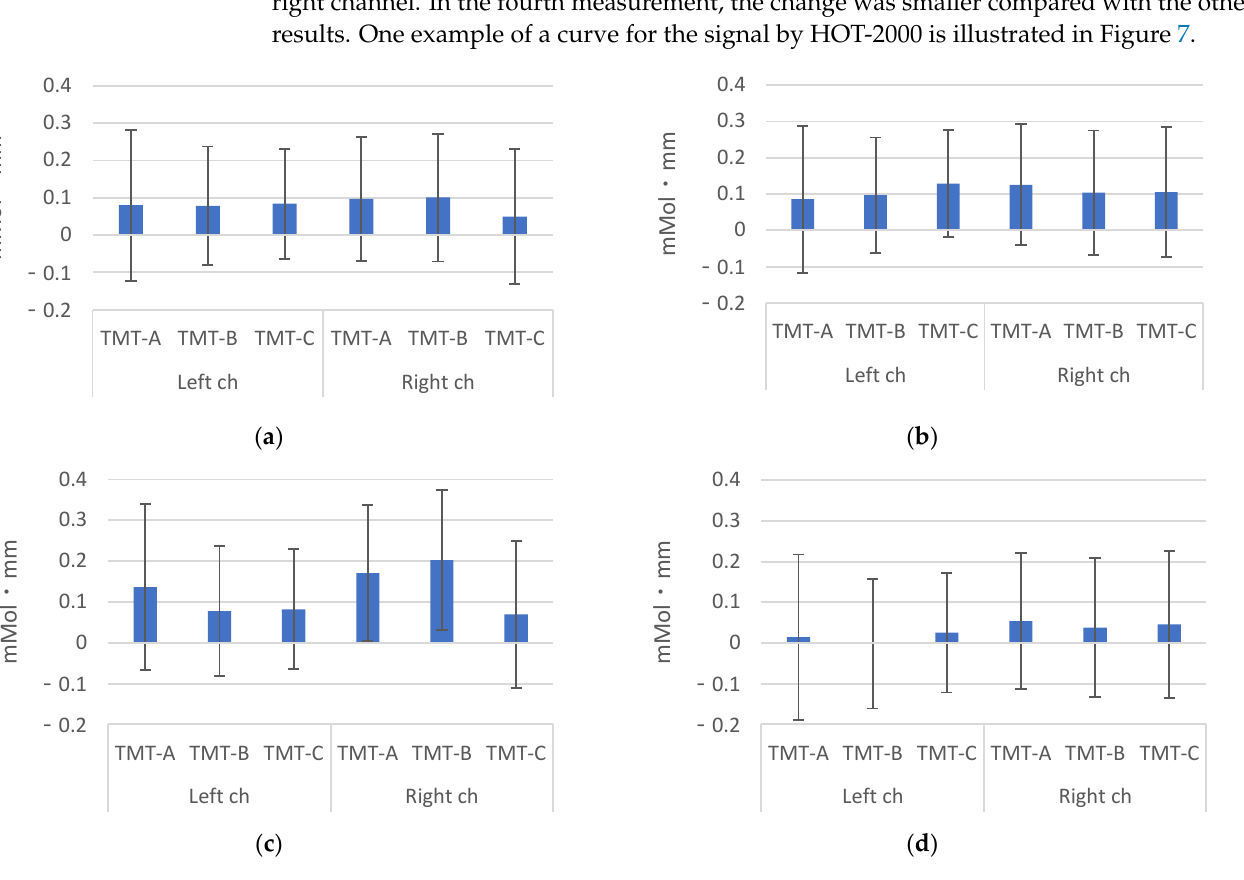
Figure 5. Salivary amylase activity monitor (for Japanese).